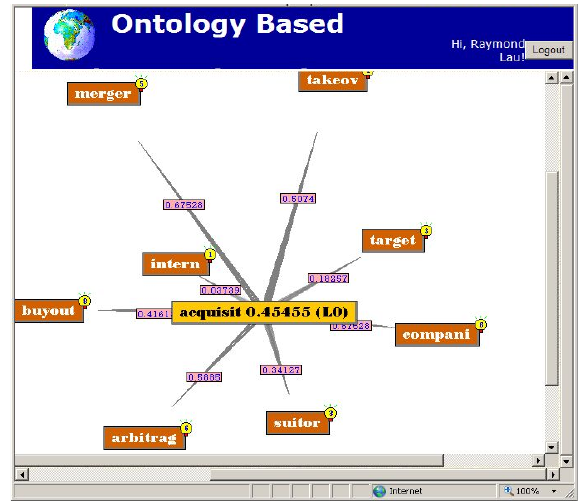
Fig. 4. The First Level Concepts of the “Acquisitions” On-